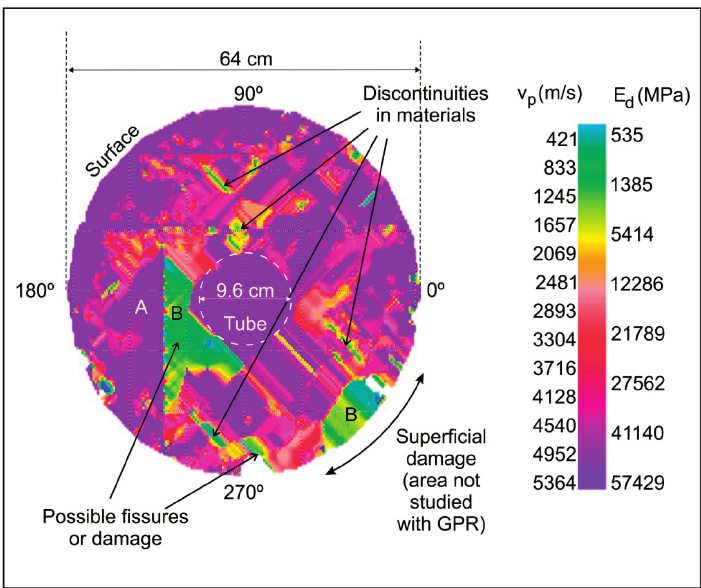
Figure 9. Seismic tomography results. Changes in seismic velocity indicate the existence of different zones and irregular